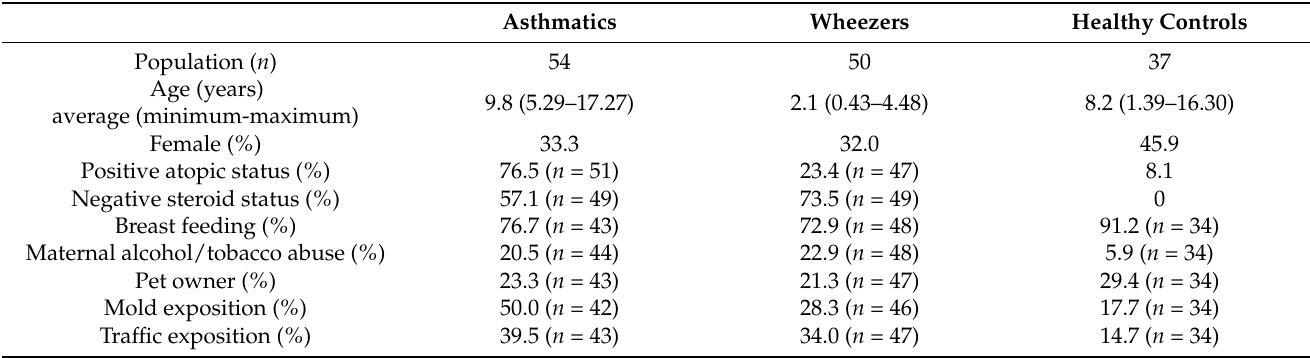
Table 2. Descriptive summary of patient characteristics.